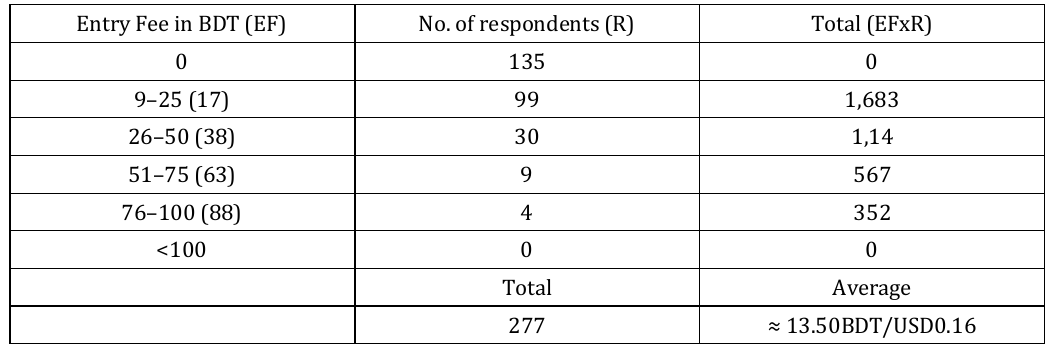
Table 3. Summary of proposed entry